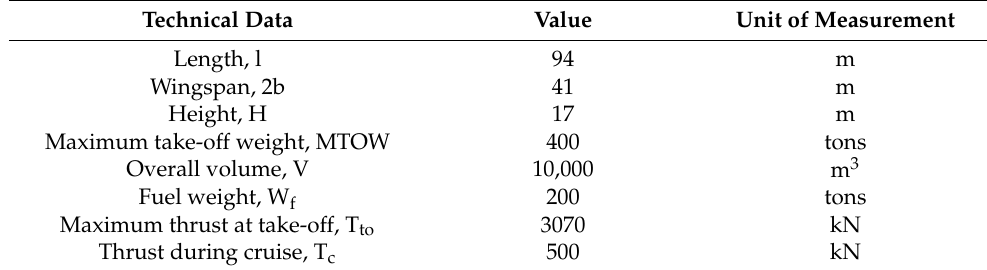
Table 1. Main technical data for the STRATOFLY